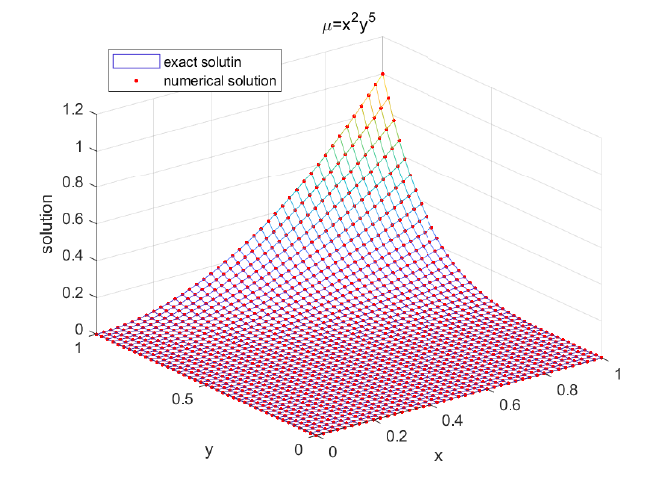
Figure 1. Comparison of numerical and exact solutions.